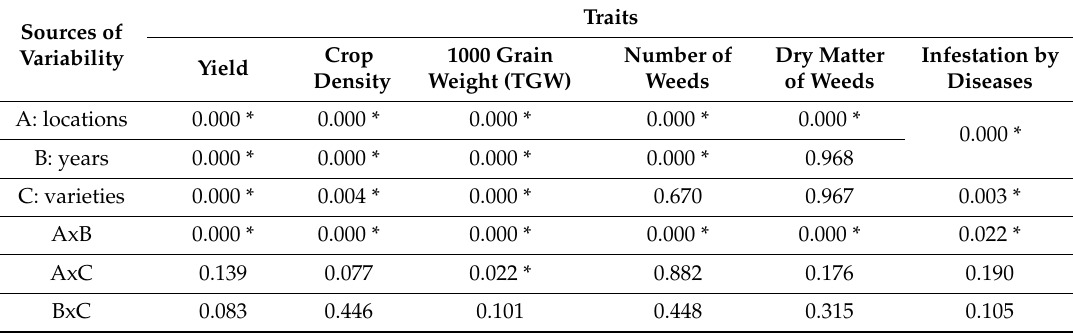
Table 4. The level of significance of F tests corresponding to sources of variability of the analysis of variance from 3 years of research (2014–2016) and 3 locations for the analyzed traits ( n = 36). Sources